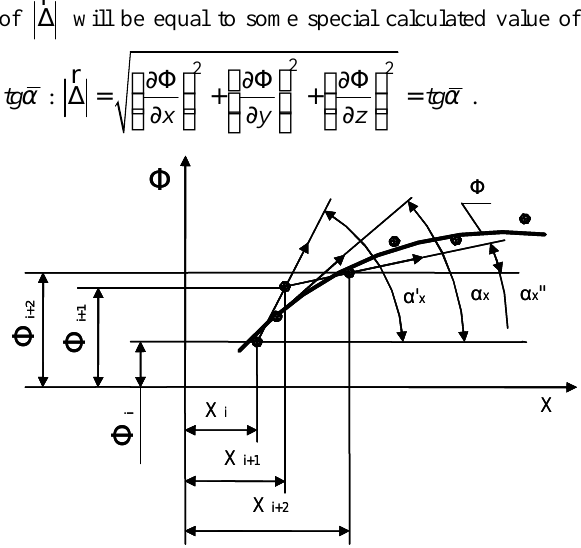
Fig 1. Graphical interpretation of measurement results According to Fig 1, the value of